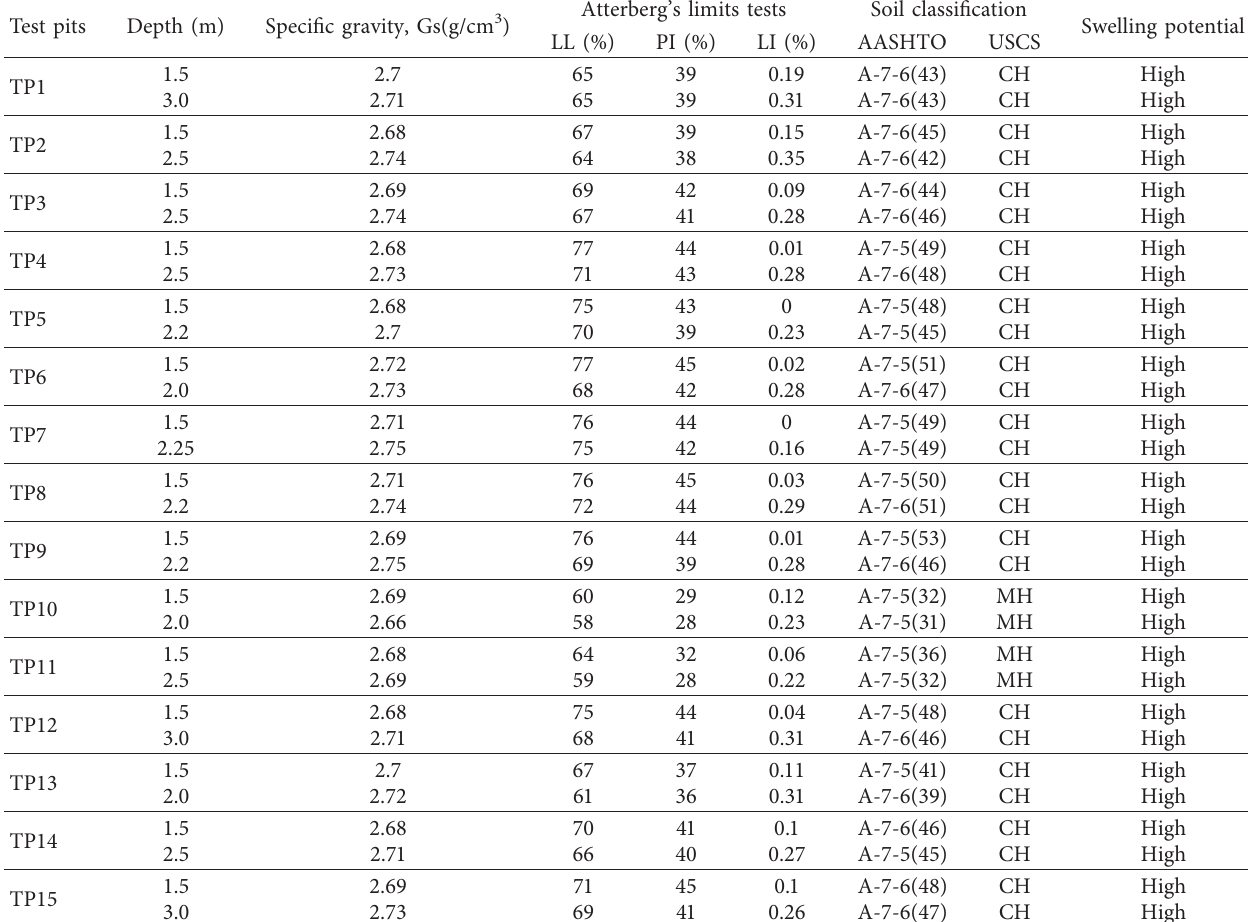
Table 2: AASHTO and USCS classification, Atterberg’s limits test